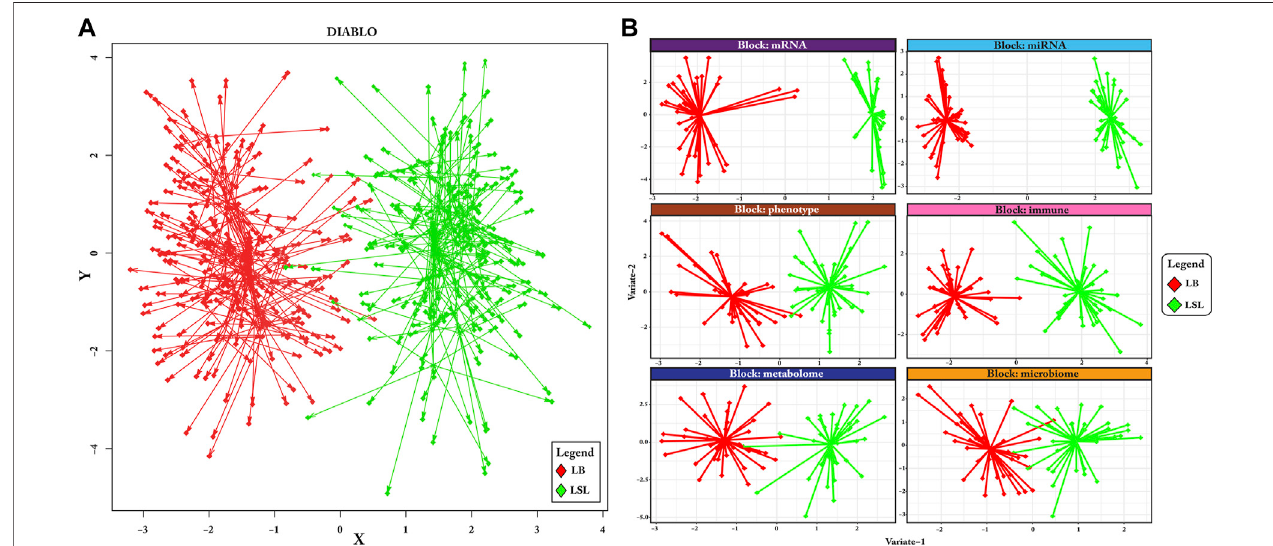
FIGURE 2 | Discriminant analysis between the two strains of laying hens, LB and LSL. (A) The arrow plot indicates the discrimination of LB and LSL hens as depicted as consensus components based on the integration of all datasets. The start of the arrow represents the components ’ score in the fi rst dimension, while the diamond symbol on the arrow ’ s tip gives the components ’ scores related to the second dimension for each individual. Short arrows indicate substantial agreement between the matching datasets, whereas long arrows depict disagreement between the matching datasets. The red and green colors represent the LB and LSL, respectively. (B) The individual plots depict six data blocks: miRNA, mRNA, phenotype, immune, metabolome, and microbiota, where each block sample showed differentiation between LB and LSL. The red is for LB and green is for